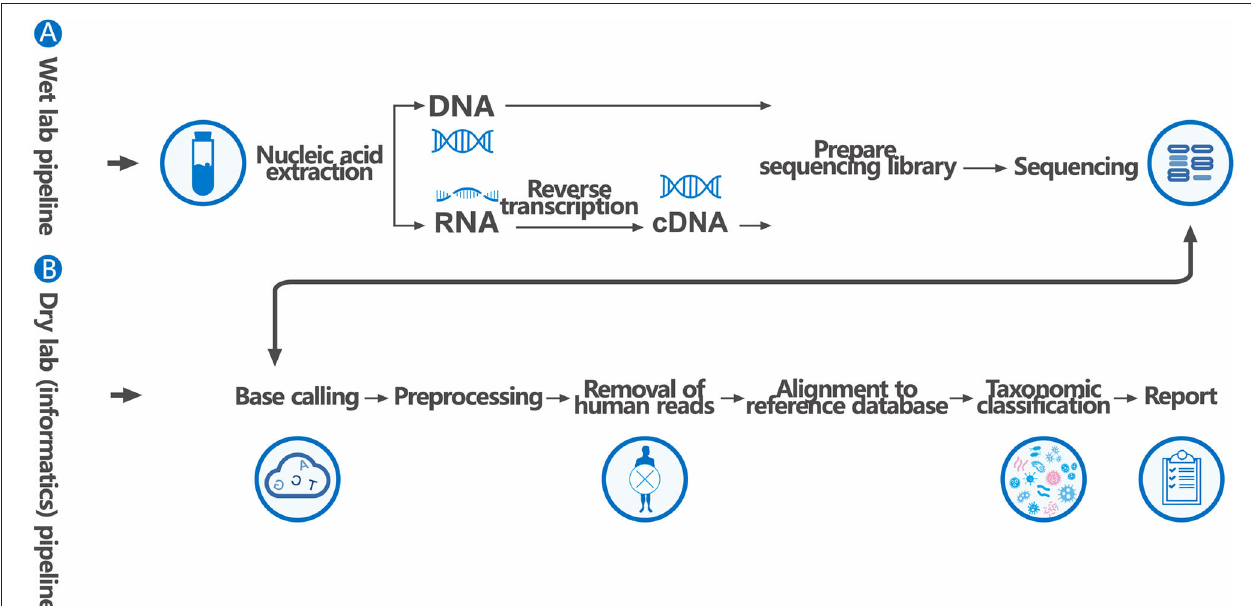
FIGURE 2 | The generalized workflow of mNGS for clinical pathogen diagnosis. The workflow has two components: (A) a wet lab protocol in which samples are collected, processed, extracted for nucleic acids, prepared into a sequencing library, and sequenced, and (B) a dry lab computational pipeline that includes microbial identification, statistical analysis, and interpretation. The sequencing library may be targeted, undergo DNA amplification, or